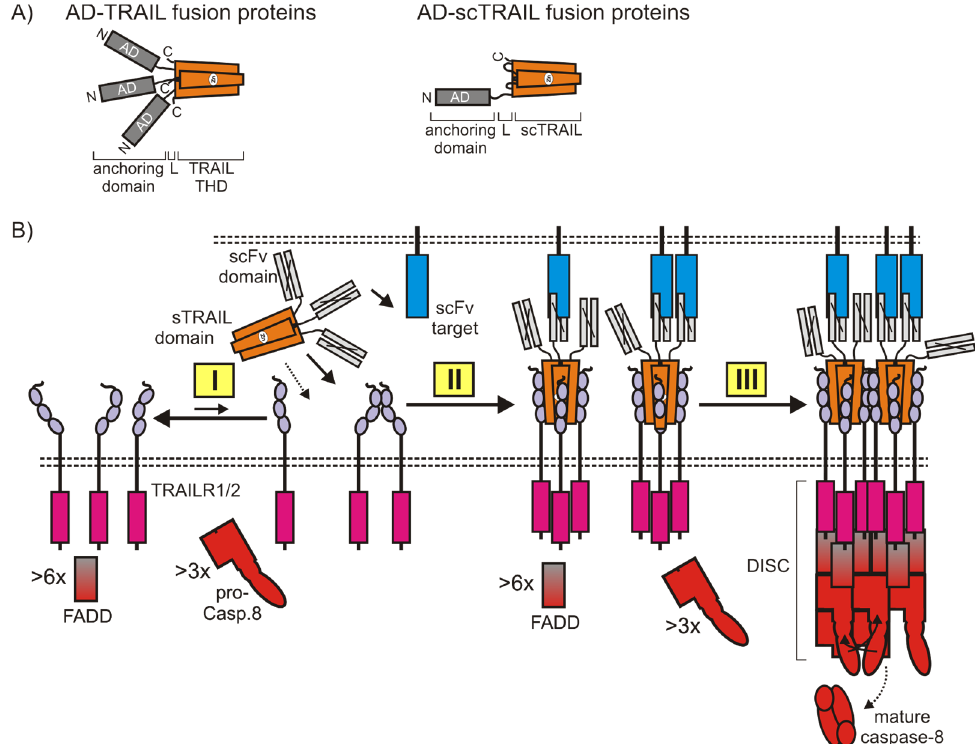
Figure 6. Cell surface anchored TRAIL fusion proteins act similarly to the membrane TRAIL. ( A ) General structure of anchoring domain (AD) TRAIL fusions proteins. Any kind of protein domain which interacts with a cell surface exposed target (scFvs, ligands …) can be considered an anchoring domain. A crucial prerequisite for anchoring-dependent agonism is only that the AD does not result in oligomerization of TRAIL trimers. ( B ) Equilibrium between monomeric and auto-associated TRAIL death receptors (I). scFv-TRAIL interacts with high a ffi nities with TRAIL death receptors and the scFv-recognized cell surface antigen (II). scFv-anchored trimeric TRAIL-TRAILR1 / 2 complexes secondarily cluster to active oligomeric networks due to the high local concentrations in the cell-to-cell contact zone and the low receptor intrinsic auto-a ffi nity. For more details, see the main text and Figures 3 and 4.